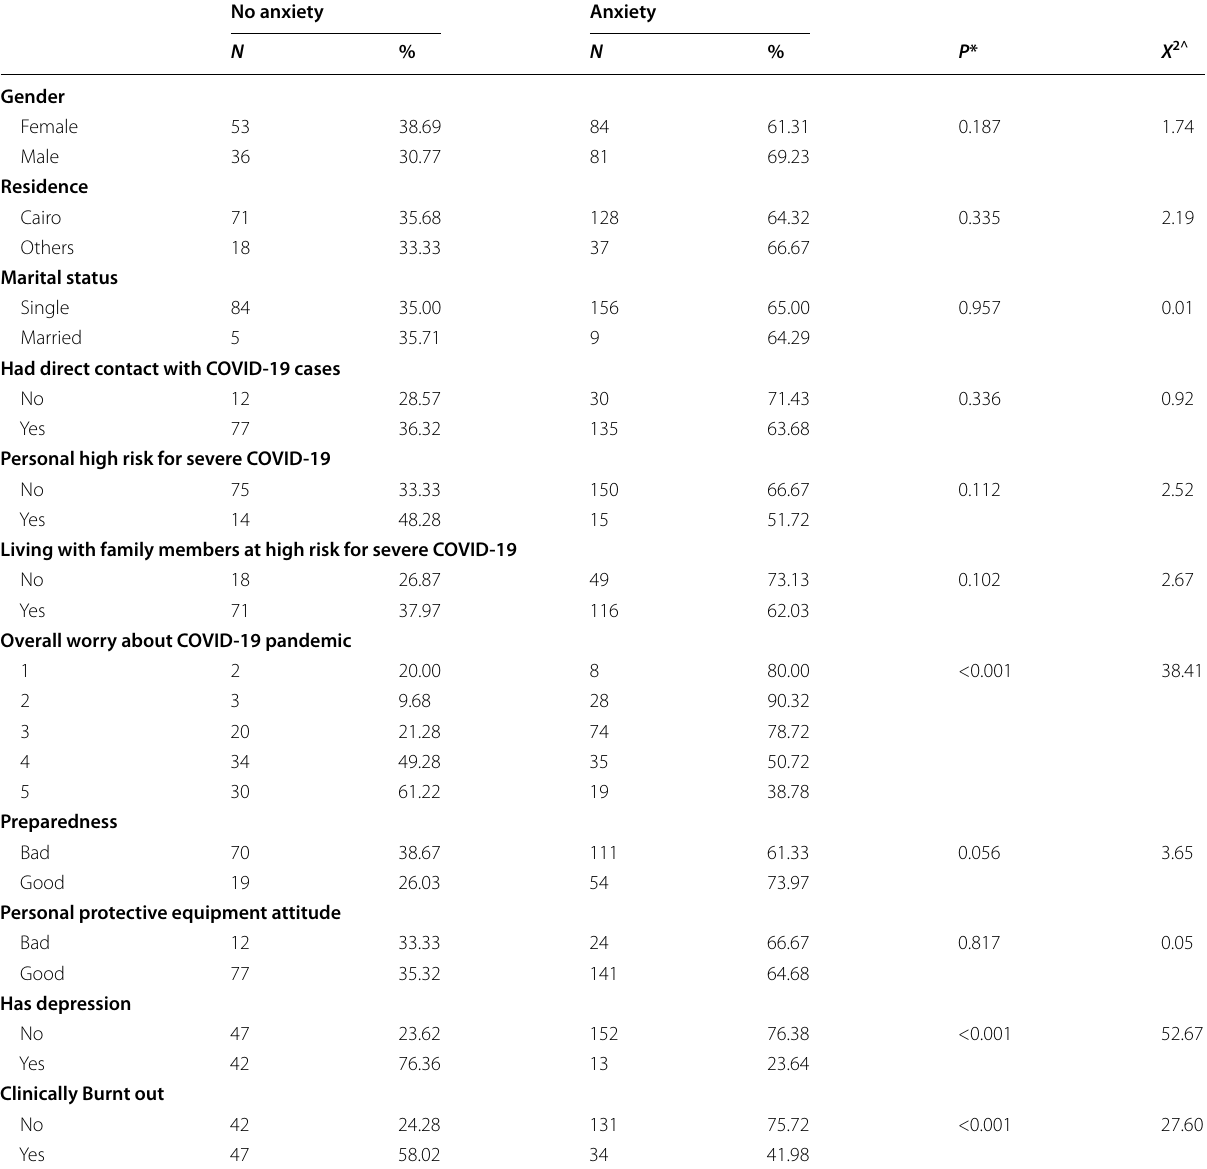
Table 3 Bivariate association between characteristics of the study population and anxiety ( N